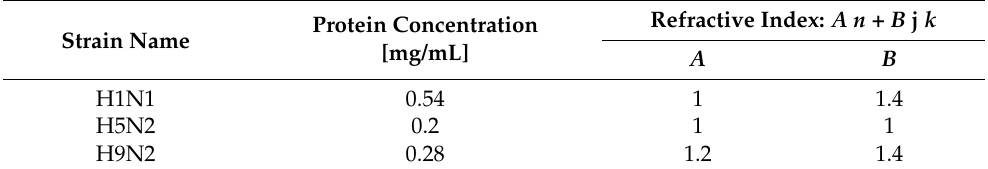
Table 1. Optical properties of three IAV strains for specific protein concentration.